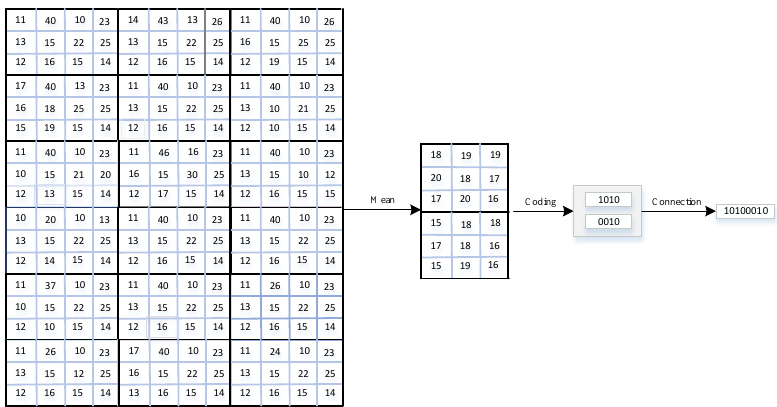
Figure 2. Process of BACS-LBP